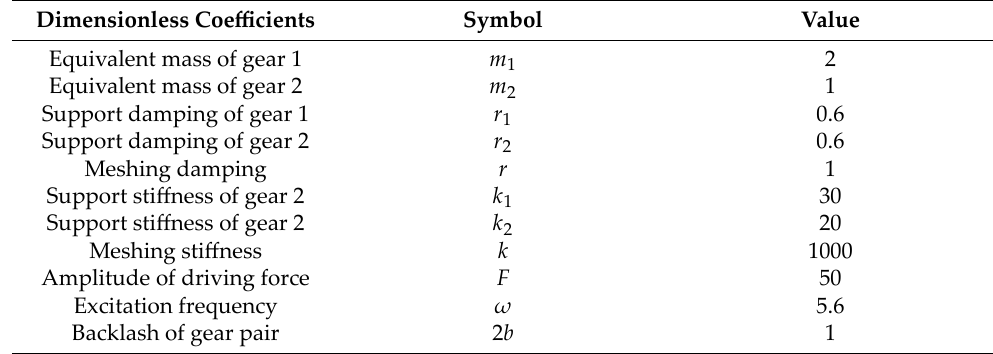
Table 1. Parameters of